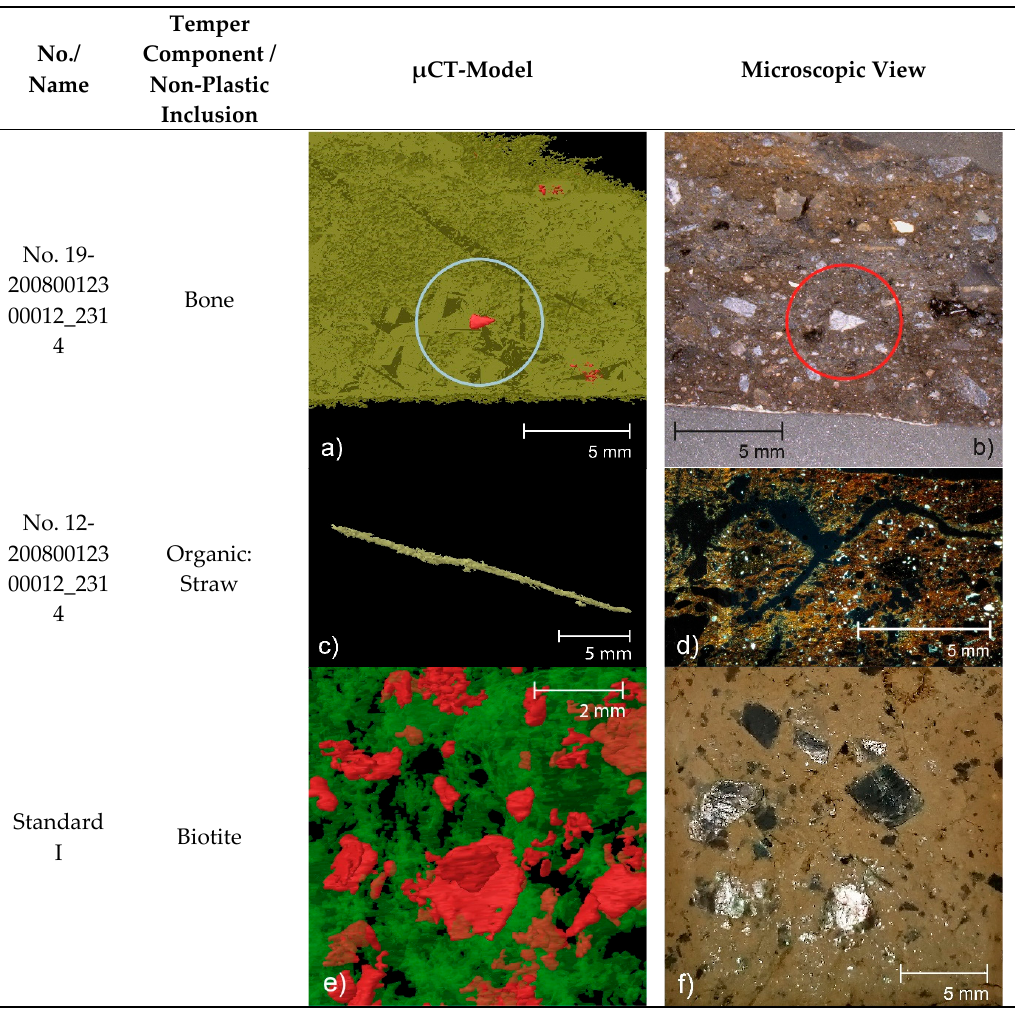
Figure 6. Examples of temper components and non-plastic inclusion in two neolithic samples and Standard I. a , b : bone fragment in sample No. 19-20080012300012_2314 (a: X-ray microtomography Standard I. ( a , b ) bone fragment in sample No. 19-20080012300012_2314 (a: X-ray microtomography (µCT) reconstruction, b: cut surface); c , d : straw as non-plastic inclusion in No. 12- ( µ CT) reconstruction, b: cut surface); ( c , d ) straw as non-plastic inclusion in No. 12-20080029600009_2008 20080029600009_2008 (c: µCT reconstruction, d: photomicrograph of thin section); e , f : mineral phase (c: µ CT reconstruction, d: photomicrograph of thin section); ( e , f ) mineral phase biotite (e: µ CT biotite (e: µCT reconstruction, biotite is in red, f: polished surface). reconstruction, biotite is in red, f: polished